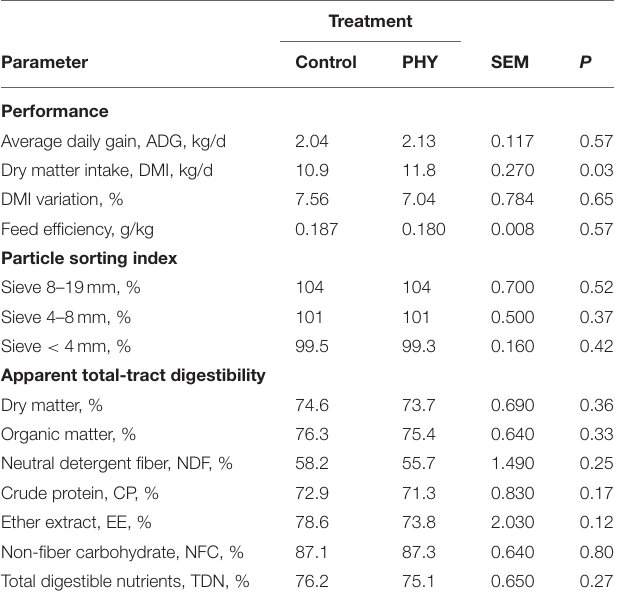
TABLE 4 | Comparison of dry matter intake, average daily gain, particle sorting index, and apparent total tract digestibility of crossbred finishing bulls during late finishing period: from day 58 to 94.